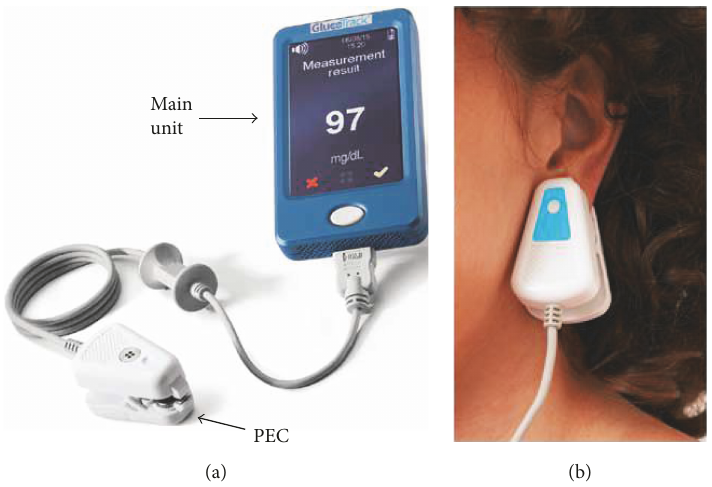
Figure 2: GlucoTrack NI monitoring device. (a) The device includes a main unit and three di ff erent sensor pairs, one per each of the three technologies, and all located at the tip of a personal ear clip (PEC). (b) Illustration of glucose measurement performance using GlucoTrack. The PEC is clipped to the earlobe for spot